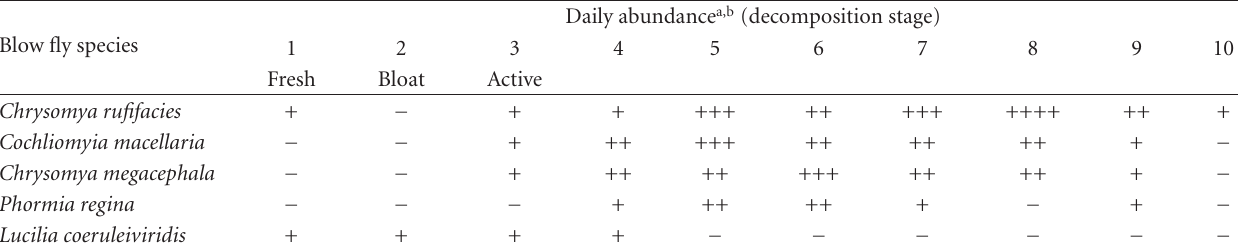
Table 1: Blow fly succession on site A’s decaying alligator, Mobile, Ala, USA (August 2002). Blow fly